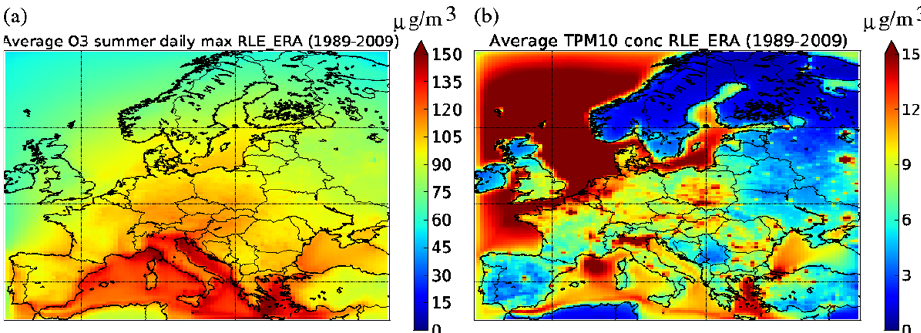
Fig. 7. Average O 3 daily maximum concentrations (June-July-August) (a) and annual average total PM 10 concentration (b) obtained with RLE ERA